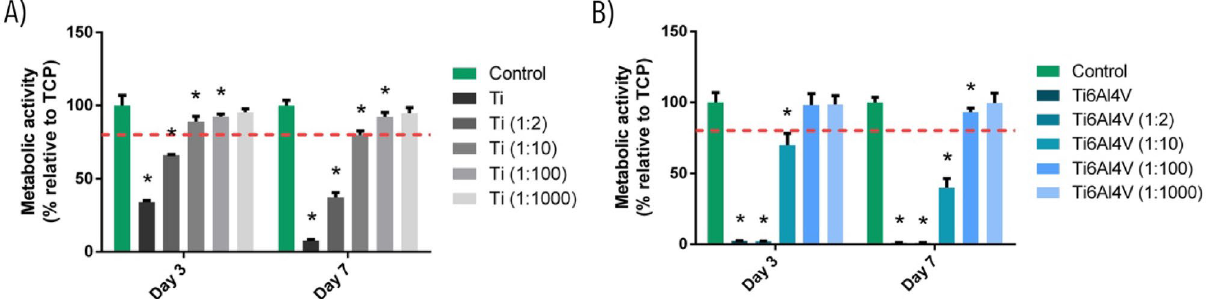
Figure 4. Effect of Ti ( A ) and Ti6Al4V ( B ) particles upon the metabolic activity of human bone marrow- derived mesenchymal stem cells (BM-MSCs) cultured for 3 and 7 days. Metabolic activity results were represented as percentage relative to an unstimulated control (TCP) and compared with the TCP of each day. Values < 80% metabolic activity (red line) which were significantly different ( p < 0.05) from TCP were considered cytotoxic. Statistically significant differences ( p < 0.05) are represented with